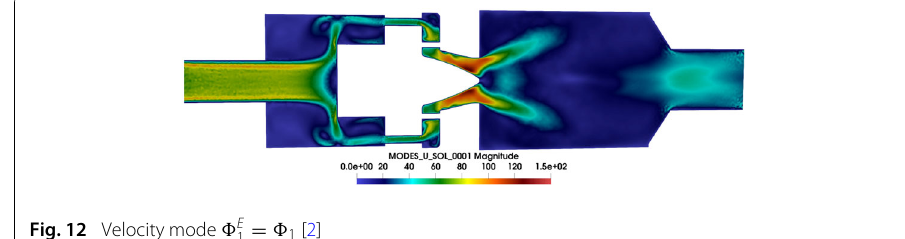
Fig. 12 Velocity mode (cid:3) E